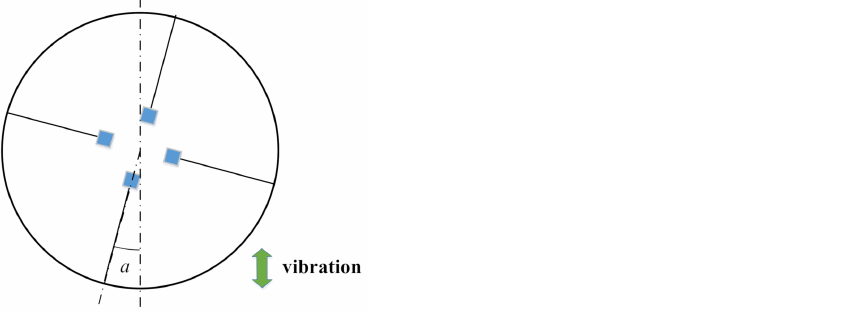
Figure 10. Schematic diagram of the vertical fixed radial deflection of the energy harvester.